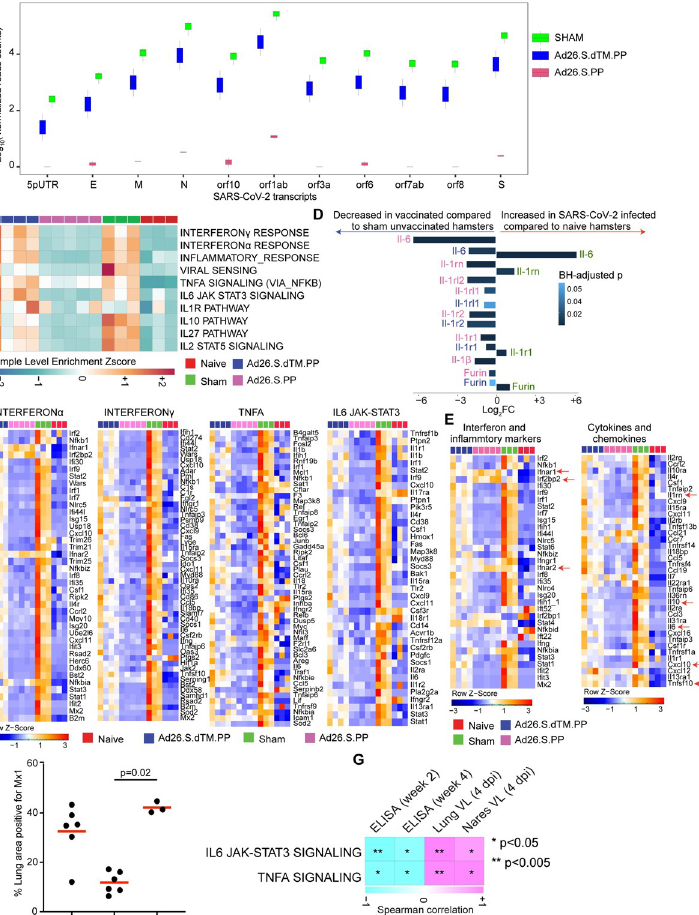
Fig 1. Proinflammatory signaling pathways were decreased in Ad26.COV2.S vaccinated compared to sham unvaccinated hamsters. (A) Boxplots of SARS-CoV-2 transcripts normalized read counts across all animals, vaccinated hamsters are shown in blue and pink, and sham animals in green. (B) Sample-enrichment analysis (SLEA) of inflammatory pathways and interferon signaling increased by SARS-CoV-2 at 4 dpi in sham unvaccinated hamsters (in green) and decreased in vaccinated hamsters (in pink and blue) compared to na ï ve uninfected animals (in red). Heatmap presenting the SLEA z-score of each of these pathways. SLEA represents the mean expression of all significant genes within each pathway for each animal. An SLEA z-score greater than 0 corresponds to a pathway for which member genes are up-regulated, while an SLEA z-score inferior to 0 corresponds to a pathway with genes downregulated in that sample. Columns correspond to individual animals, and rows correspond to individual pathways scaled across all animals using the z-score R function. (C) Gene heatmaps of the row scaled expression of the leading genes from pathways shown in panel A increased or decreased at 4 dpi in vaccinated hamsters compared to sham unvaccinated and control na ï ve animals. Adjusted P-values ( < 0.05) were calculated by DEseq2 using Benjamini- Hochberg corrections of Wald test p-values. Columns correspond to individual animals, and rows correspond to individual genes. (D) Bar plots represent the log2 fold change mRNA expression of IL-6, IL-1, IL-1R, and Furin across all groups. The length of the bar plot represents the log 2 -fold change compared to control animals, and the color gradient corresponds to the BH-adjusted p-values for each gene. (E) Heatmaps of proinflammatory markers and proinflammatory cytokines at 4 dpi in vaccinated hamsters compared to sham unvaccinated and control na ï ve animals. Adjusted P-values ( < 0.05) were calculated by DEseq2 using Benjamini-Hochberg corrections of Wald test p- values. Columns correspond to individual animals, and rows correspond to individual genes scaled across all animals. (F) Percent area of lung tissue staining positive for Mx1. Mx1 = myxovirus protein 1 (type 1 interferon-inducible gene) in vaccinated compared to sham unvaccinated hamsters. Kruskall-Wallis one-way ANOVA followed by Dunn’s multiple comparisons test. Red line = median. (G) Correlation matrix plot showing the Spearman correlation of interferon and inflammatory signatures at 4 dpi with viral loads in hamster’s lung and nares at 4 dpi and neutralizing and binding antibody titers at weeks 2–4 post-vaccination. Negative correlations were shown in cyan, and positive correlations were shown in